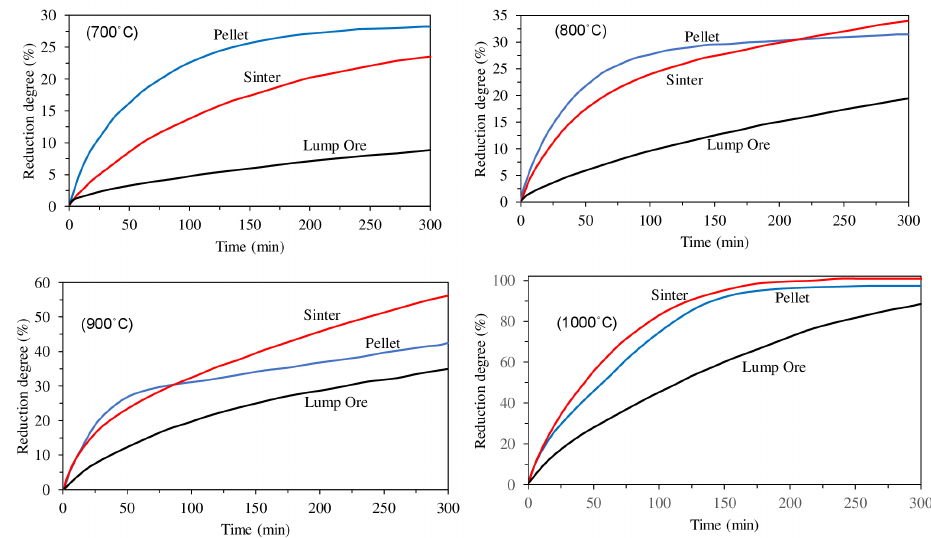
Figure 11. Reduction degree as a function of time for iron ore pellet, sinter, and lump ore at 700, 800, 900, and 1000 °C [44] “modified”.